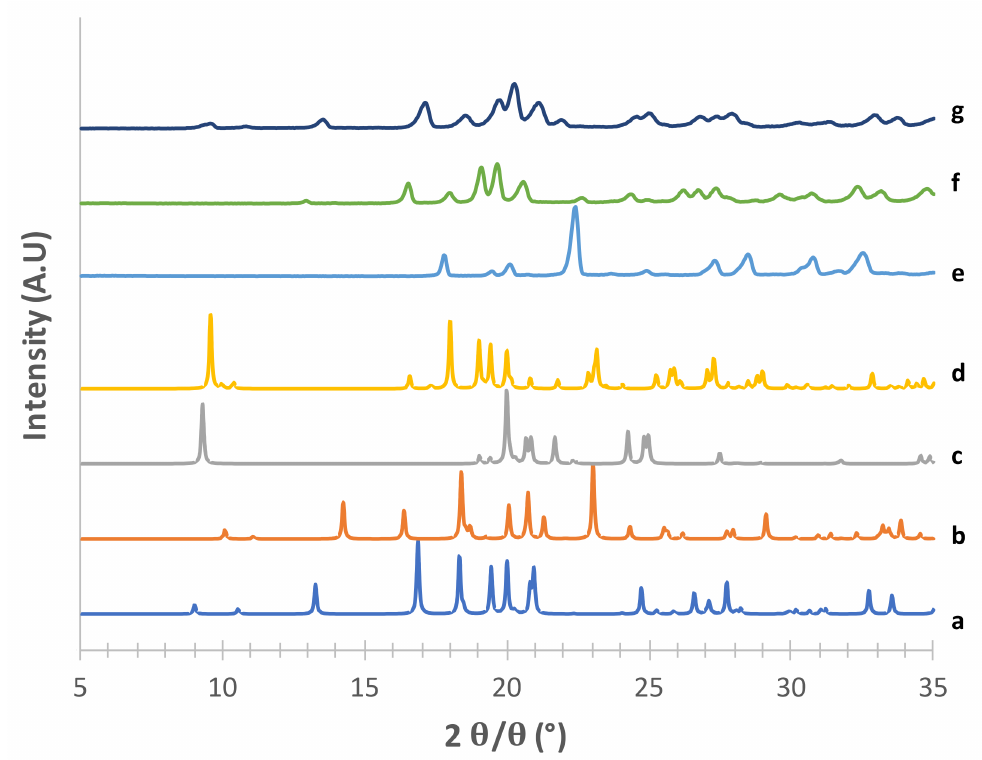
Figure 1. PXRD patterns of the supposed mannitol α form (g) prepared in a saturated methanol so- lution using 2% of PVA (f) 1% of PVA, (e) without PVA. Patterns of all polymorphs are added as references (a) α form CCDC 224658, (b) β form CCDC 224659, (c) δ form CCDC 224660, (d) hemihydrate form CCDC